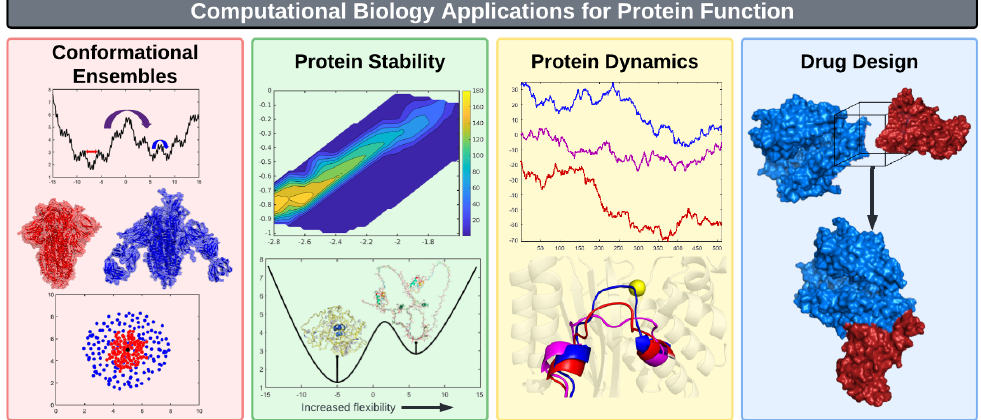
Figure 2. Four pillars of computational biology: The role of protein structure is critical in all pan- els. Conformational ensembles, red panel: ML helps with: ( i ) enhanced sampling; ( ii ) identifying collective variables; ( iii ) automated potential biasing; and ( iv ) Markovian state space partitioning. Protein stability, green panel: ML helps with ( i ) modeling the role of environment; ( ii ) protein en- gineering through mutagenesis; ( iii ) characterization of protein–protein interactions; and ( iv ) the role of rigidity for protein function. Protein dynamics, yellow panel: ML helps with ( i ) protein flexibility/conformational dynamics; ( ii ) dynamic allostery; and ( iii ) potential energy/force fields. Drug discovery, blue panel: ML helps with ( i ) molecular docking; and ( ii ) binding affinity